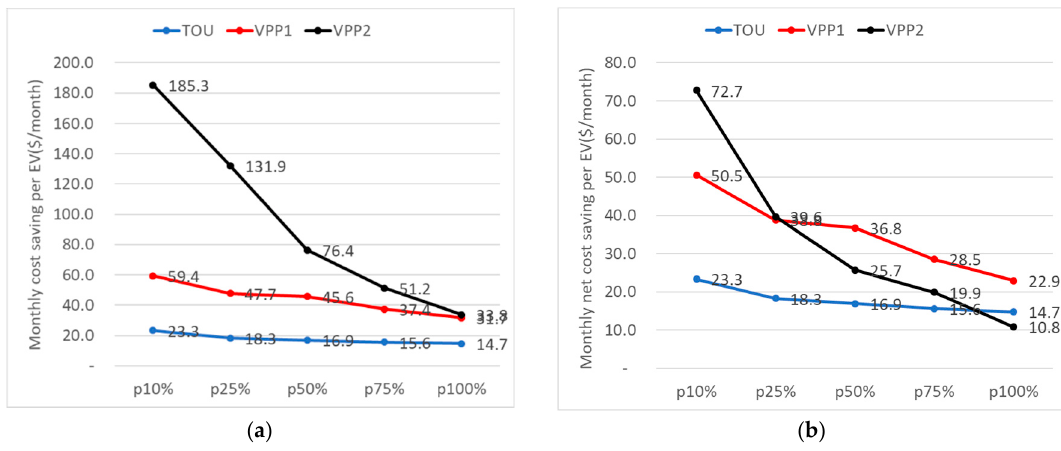
Figure 15. Monthly gross cost saving and net cost saving per EV by varying participation rates (USD/month): ( a ) gross cost saving; ( b ) net cost saving.